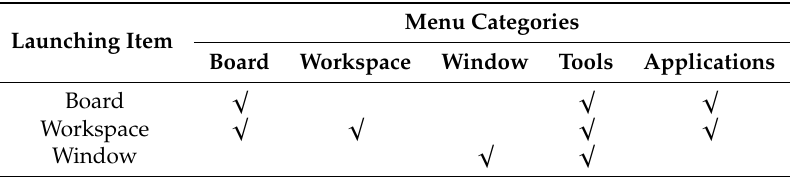
Table 4. Context-sensitive menu